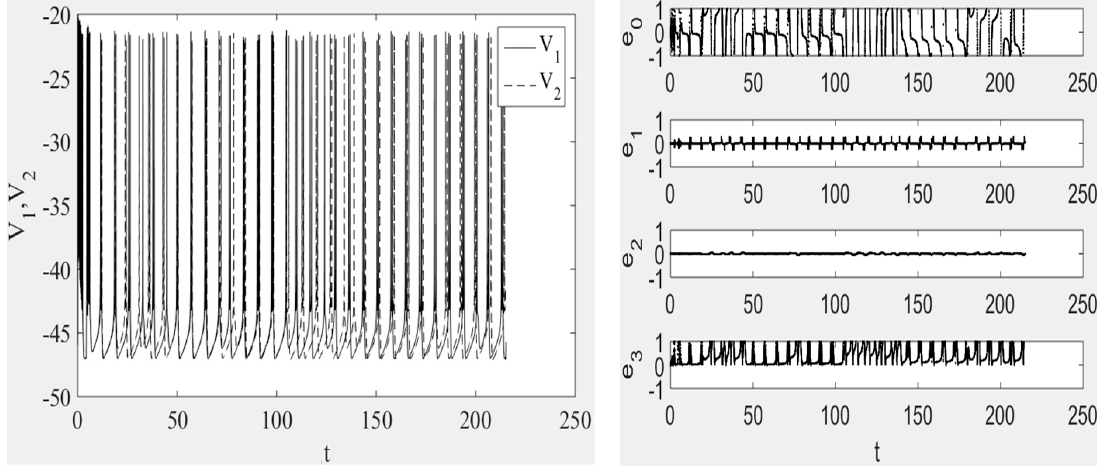
Figure 9. Time histogram and synchronization discrepancy graph when H syn = 1.55 and τ = 3.4.